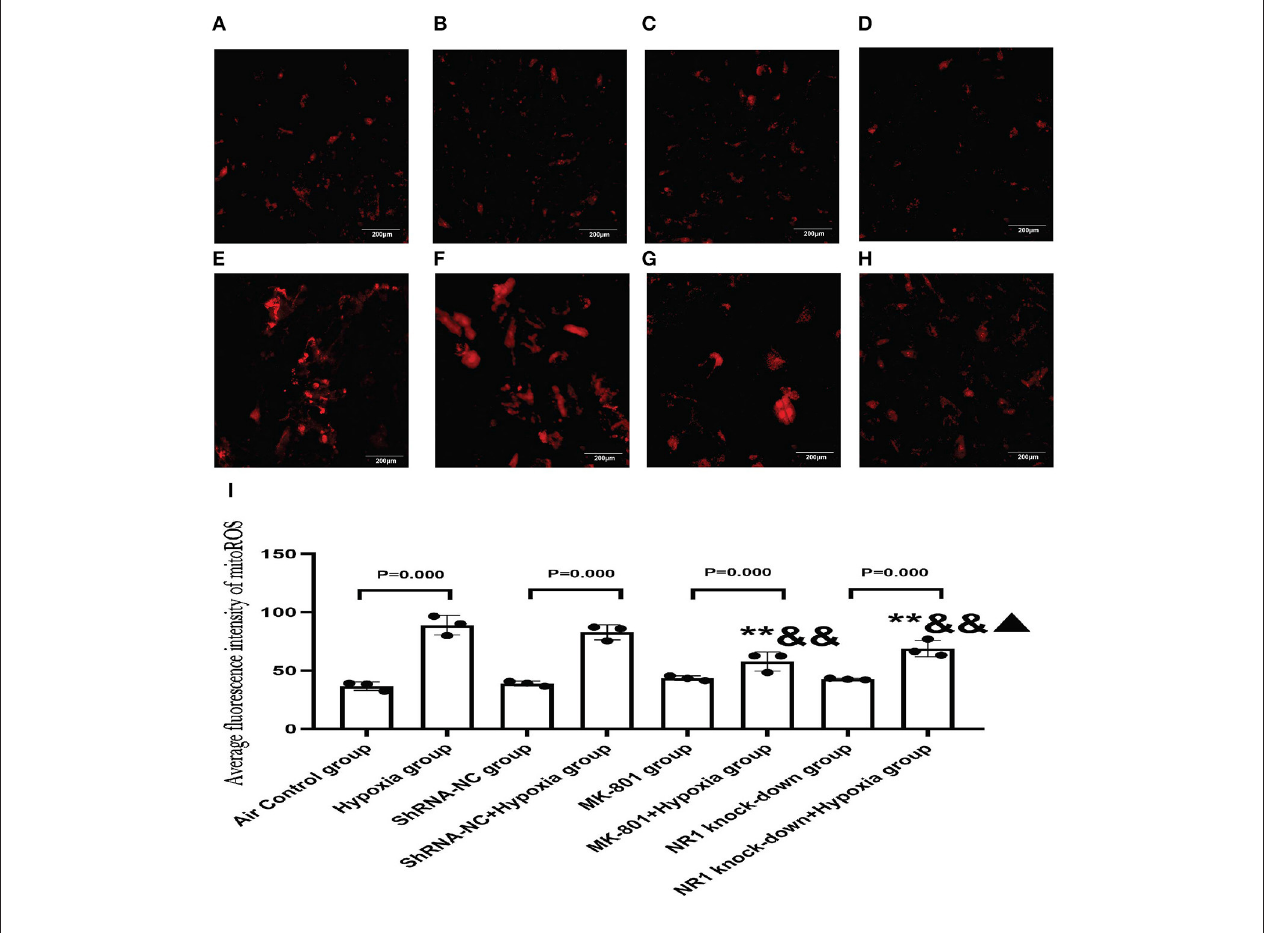
FIGURE 8 | MitoSOX TM Red staining for measuring mitoROS level. (A–H) The representative florescence images of MitoROS (200x). (A–D) : Air control group (A) , shRNA-NC group (B) , MK-801 group (C) , and NR1 knock-down group (D) ; (E–H) : Hypoxia group (E) , shRNA-NC + hypoxia group (F) , MK801 + hypoxia group (G) , and NR1 knock-down + hypoxia group (H) ; (I) the average intensity of mitoROS fluorescence. Compared with the hypoxia group: * P < 0.05, ** P < 0.01; compared with the shRNA-NC + hypoxia group: & P < 0.05, && P < 0.01; compared with the MK-801 + hypoxia group: N P < 0.05, NN P < 0.01. All data are presented as mean ± S.E.M. ( N =